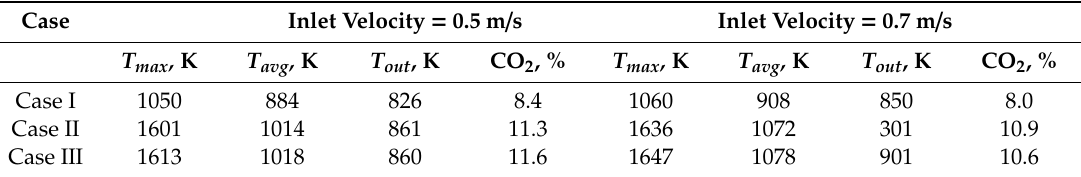
Table 5. A summary of Maximum and average combustor temperatures along with area weighted average of CO 2 mass fraction at the combustor outlet.